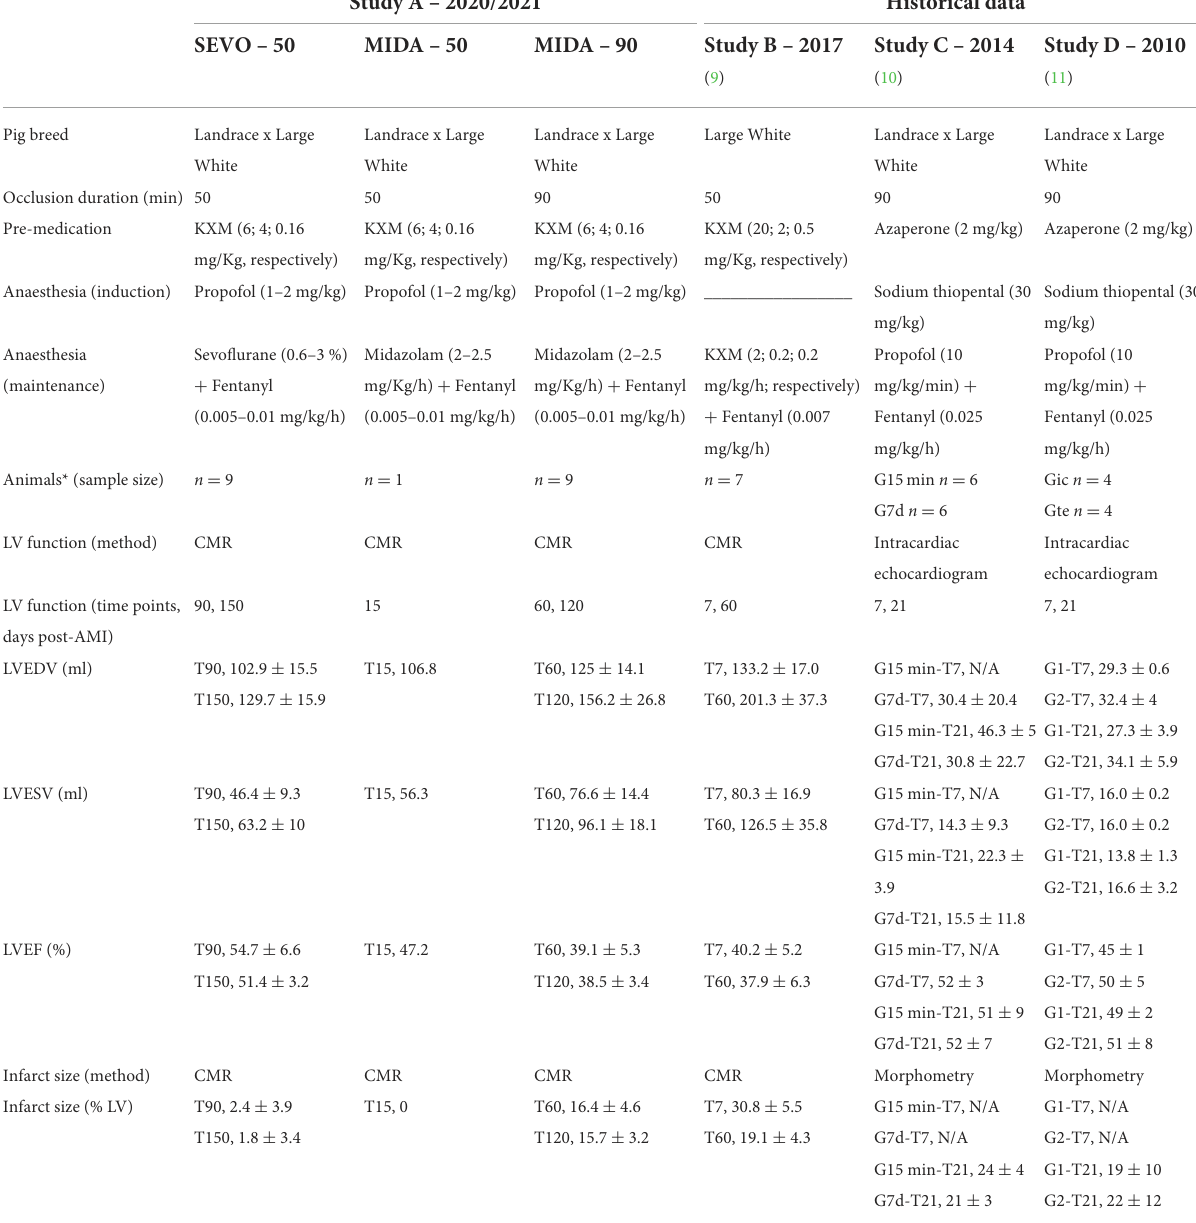
TABLE 1 Pig breed, ischaemia time, anaesthetic regimens, and echocardiography or CMR results from the present study and previous publications of our research